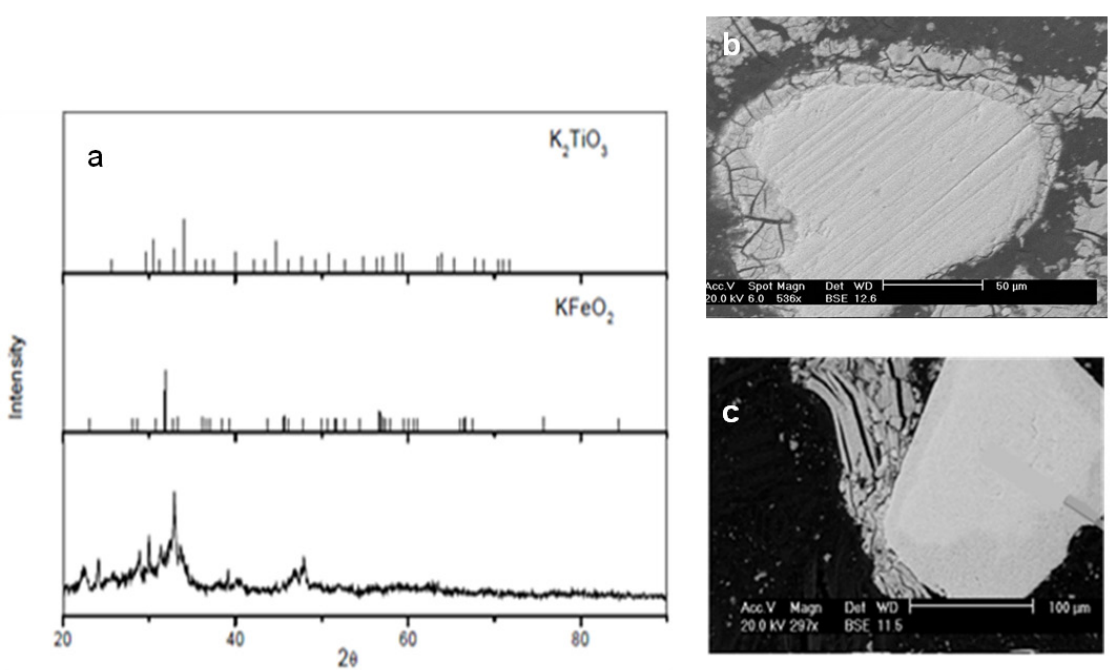
CO ; (b) Backscattered image of ilmenite roasted with KOH at 500 o C; (c) Back 2 3 CO at 900 o C. 2 3